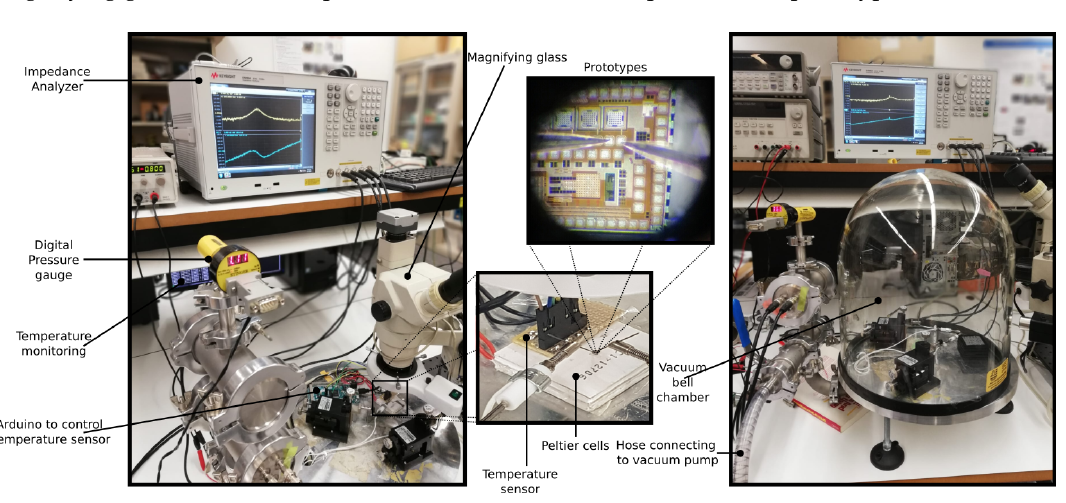
Figure 5. Measurement